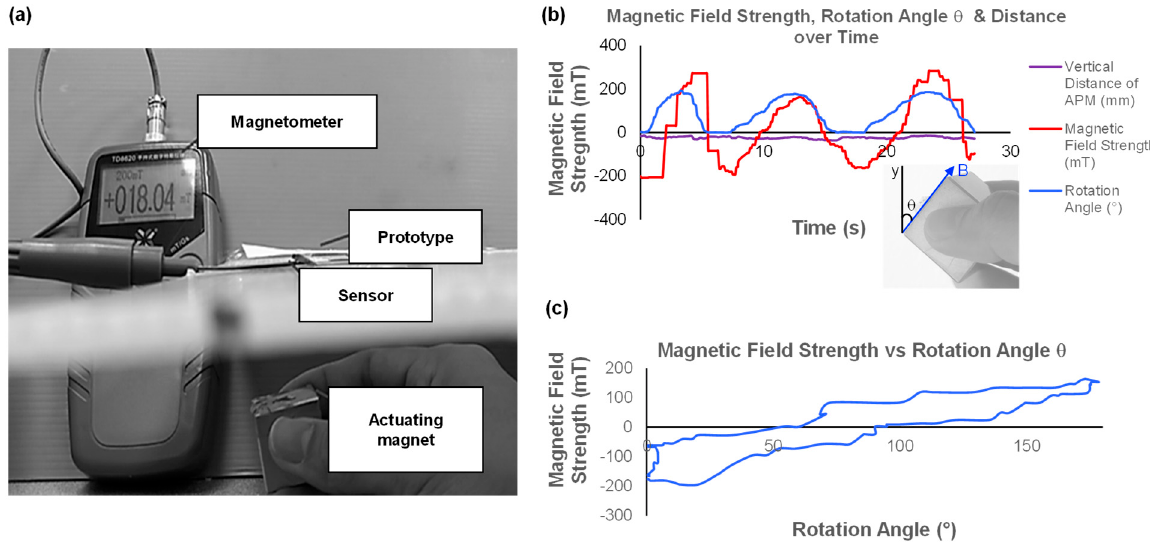
Figure 5. Using magnetometer to measure magnetic field strength. ( a ) The magnetometer sensor tip is placed on the testing surface with the actuating permanent magnet placed right below it and the SLEM structure right on top. ( b ) Magnetic field strength, rotation angle θ of magnetic field, and vertical distance of APM from sensor versus time. Rotation angle θ is measured regarding the direction of the magnetic field with respect to the vertical direction. The rotation occurs anticlockwise, and once the magnet and magnetic field are completely inverted (by 180°), the magnet is rotated clockwise to revert to its original position. ( c ) Magnetic field strength plotted against rotation angle of magnetic field for one cycle.